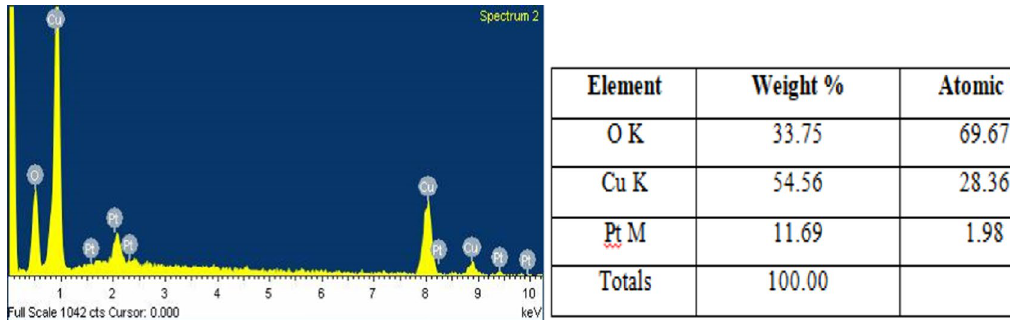
Fig. 9 EDX graph and Composition of CuO Nanoparticles